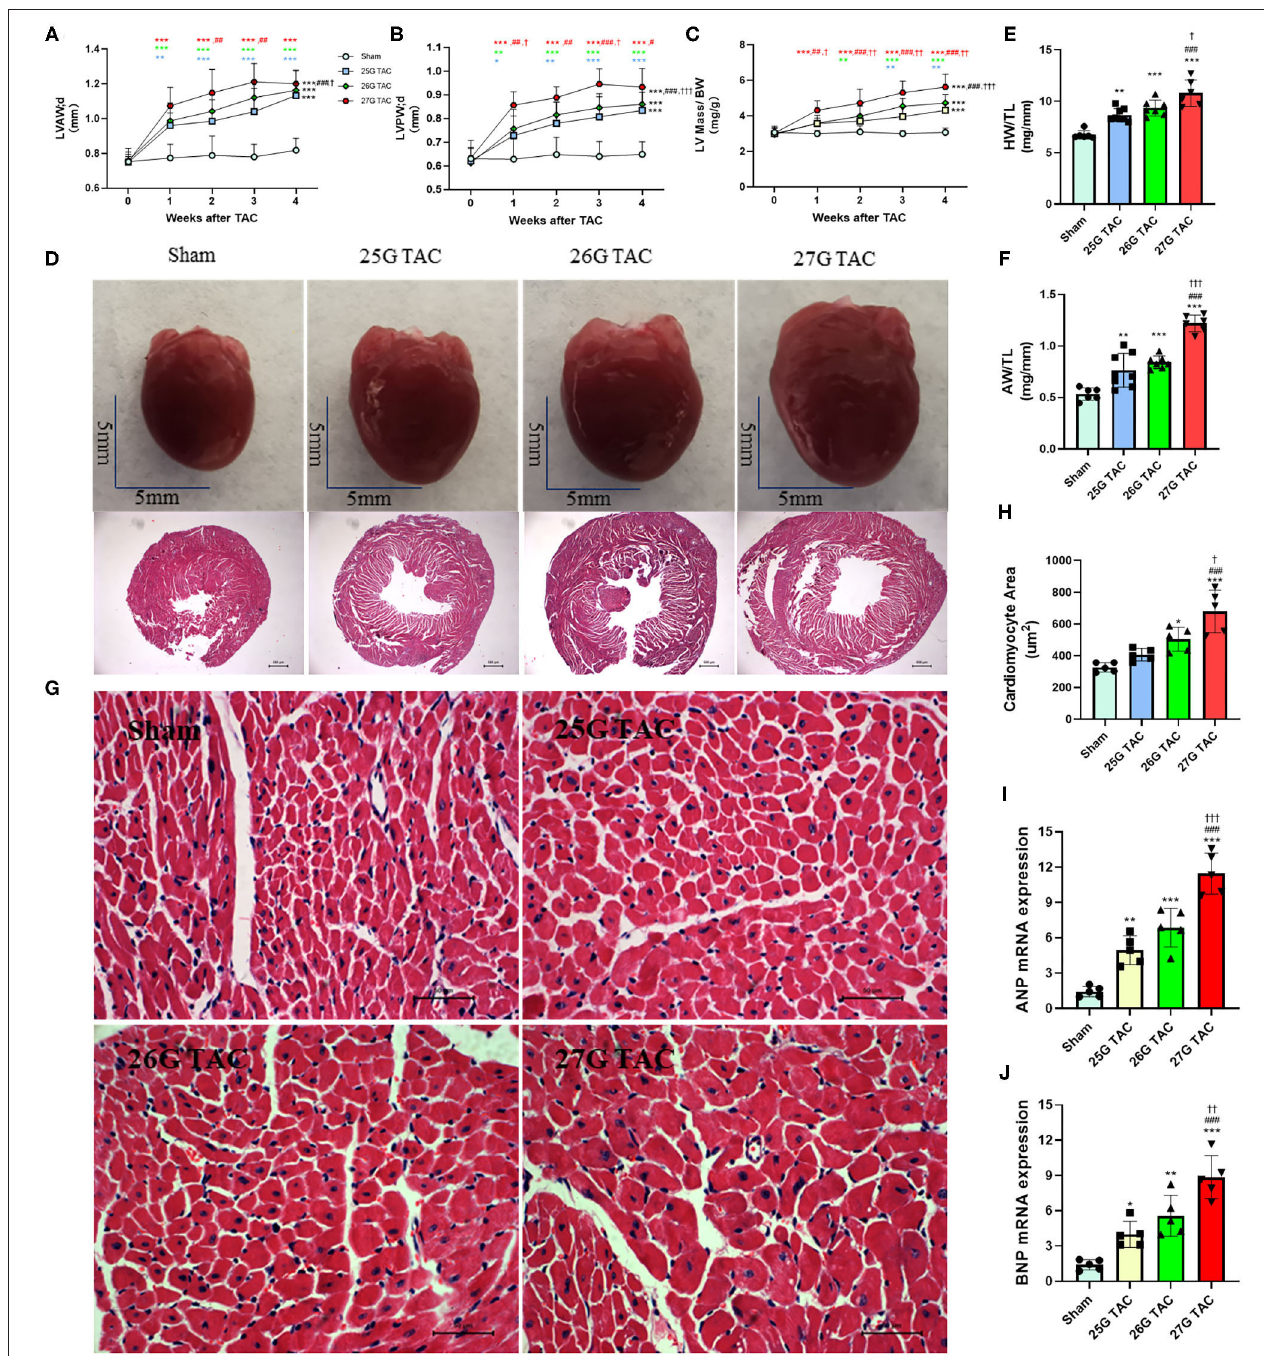
FIGURE 2 | 25, 26, and 27G TAC induced different degrees of cardiac hypertrophy in C57BL/6N mice. The echocardiography-derived results of (A) the LVAW thickness, (B) LVPW thickness, and (C) LV mass normalized to body weight. (D) Representative heart pictures for sham, 25, 26, and 27G TAC mice after 4 weeks of TAC and representative images of H&E staining of cross-heart sections; scale bars 500 um. (E) HW/TL and (F) AW/TL in sham, 25, 26, and 27G TAC mice after 4 weeks of TAC. (G) Representative LV sections stained with H&E and DAPI (blue) for assessment of cardiomyocyte area. Scale bar = 50 µ m. (H) Quantification of cardiomyocyte area. (I,J) RT-PCR analysis of ANP and BNP mRNA. * P < 0.05, ** P < 0.01, and *** P < 0.001 vs. sham, # P < 0.05, ## p < 0.01, ### p < 0.001 vs. 25G, † P < 0.05, †† P < 0.01, and ††† P < 0.001 vs. 26G TAC, TAC by two- (A–C) or one-way ANOVA (E,F,H) with Tukey’s post-test. Colored symbols (A–C) indicate * P < 0.05, ** P < 0.01, and *** P < 0.001 vs. sham, # P < 0.05, ## p < 0.01, ### p < 0.001 vs. 25G, † P < 0.05, †† P < 0.01 vs. 26G TAC at the time point indicated.